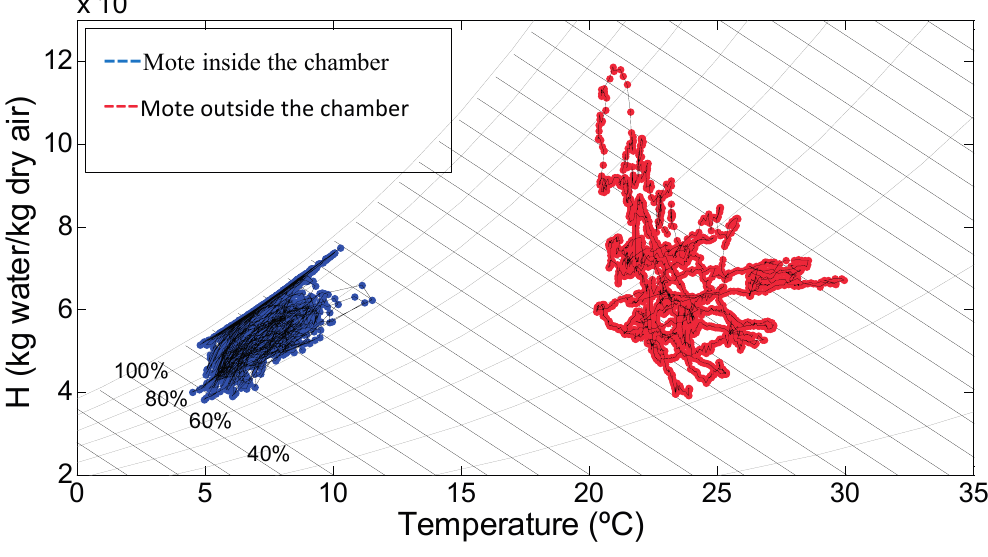
Figure 5. Psychrometric chart in Chamber 29.